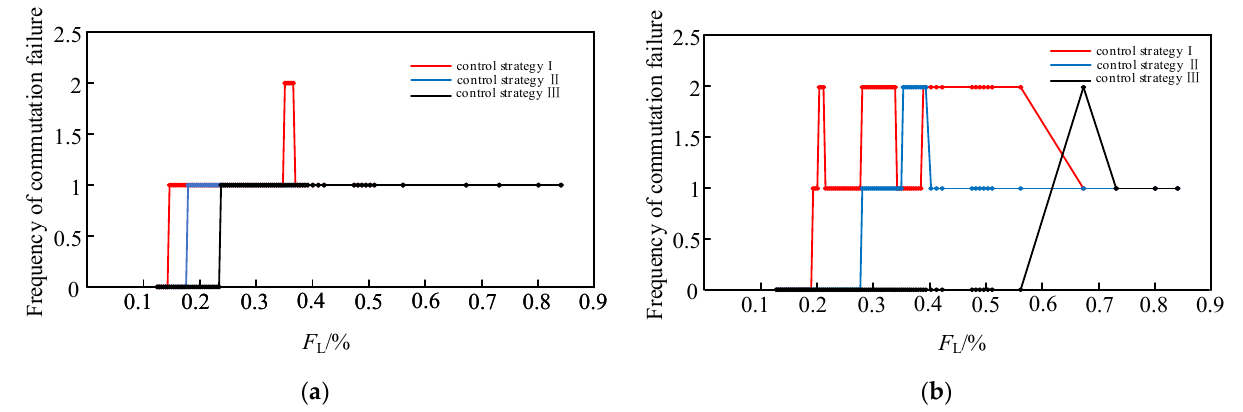
Figure 14. The suppression ability under different strategies to commutation failure. ( a ) Frequency of commutation failure under three-phase short-circuit fault. ( b ) Frequency of commutation failure under single-phase short-circuit fault.